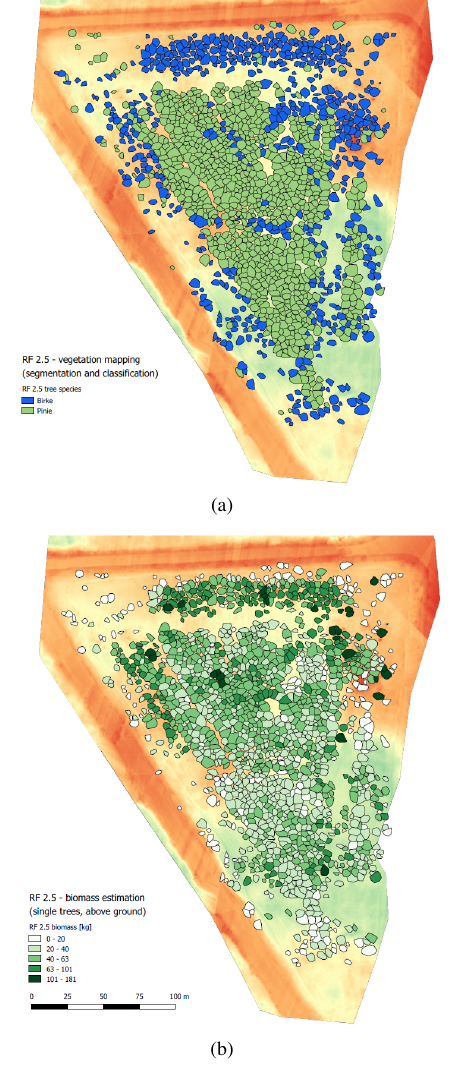
Figure 3. Study area 2: (a) Tree species classification